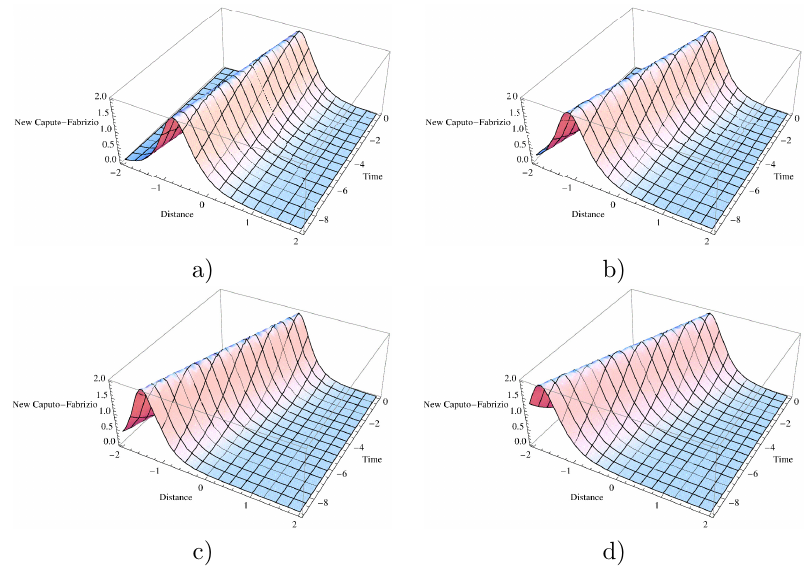
Figure 1. Solution u ( x,t ) for ν = 5, µ = 3 and: a) α = 0 . 05, b) α = 0 . 15, c) α = 0 . 85, d) α = 0 .